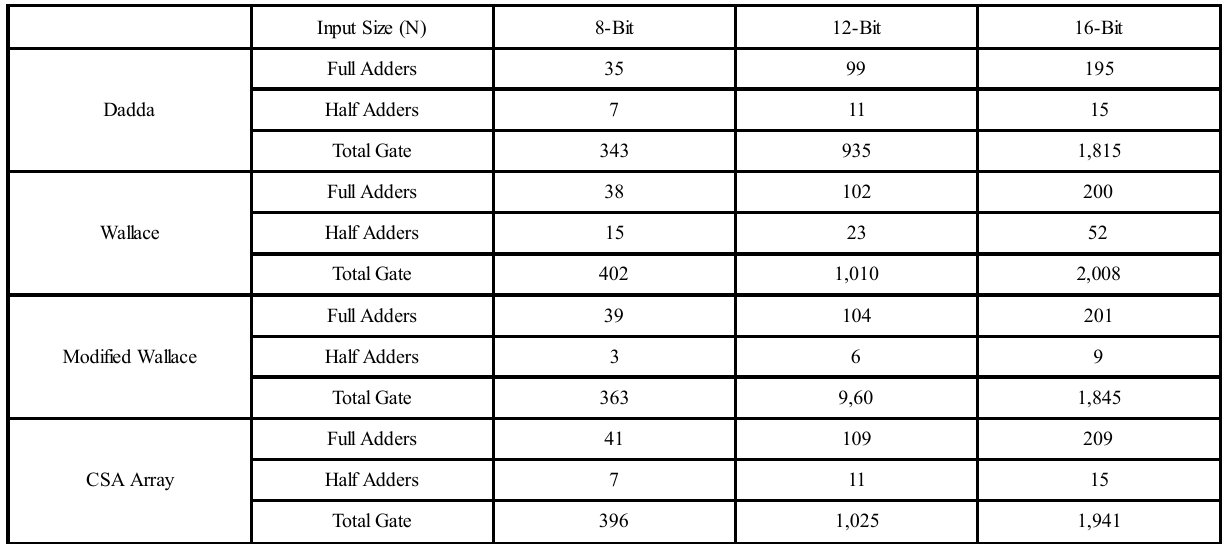
TABLE 1. GATE COUNT RESULTS OF PARENT TREE MULTIPLIERS